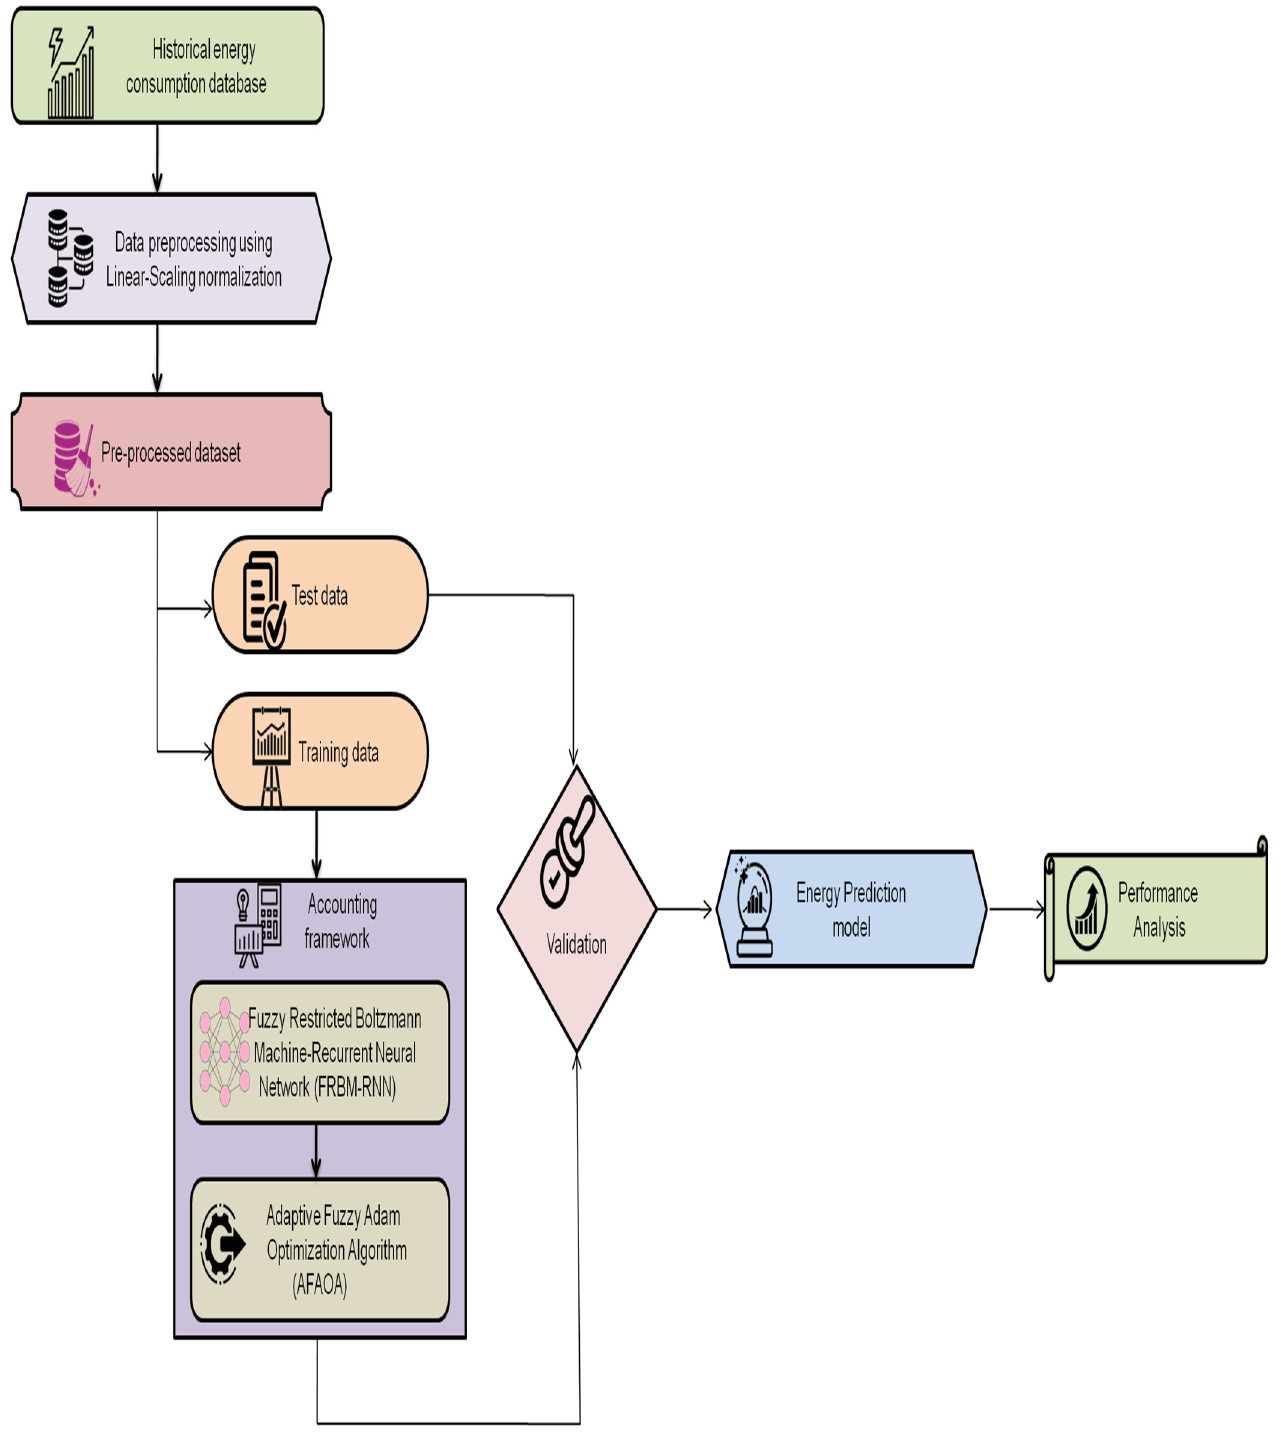
Figure 2. Flow of the proposed work [Source: Author].